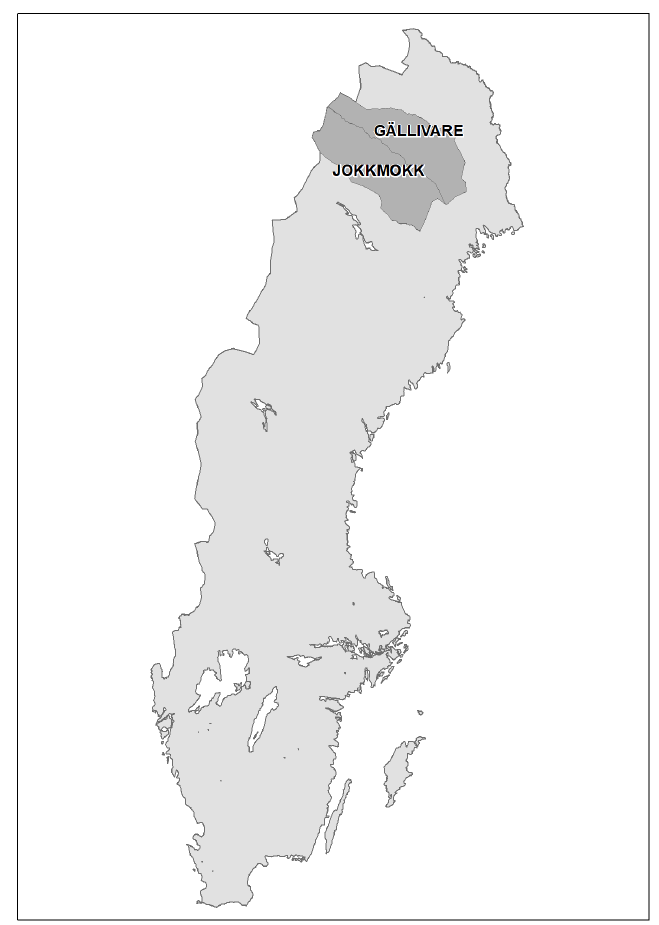
Figure 1. Map of Sweden including the study area of Jokkmokk and Gällivare. Reproduced with permission from the Swedish National Archives.